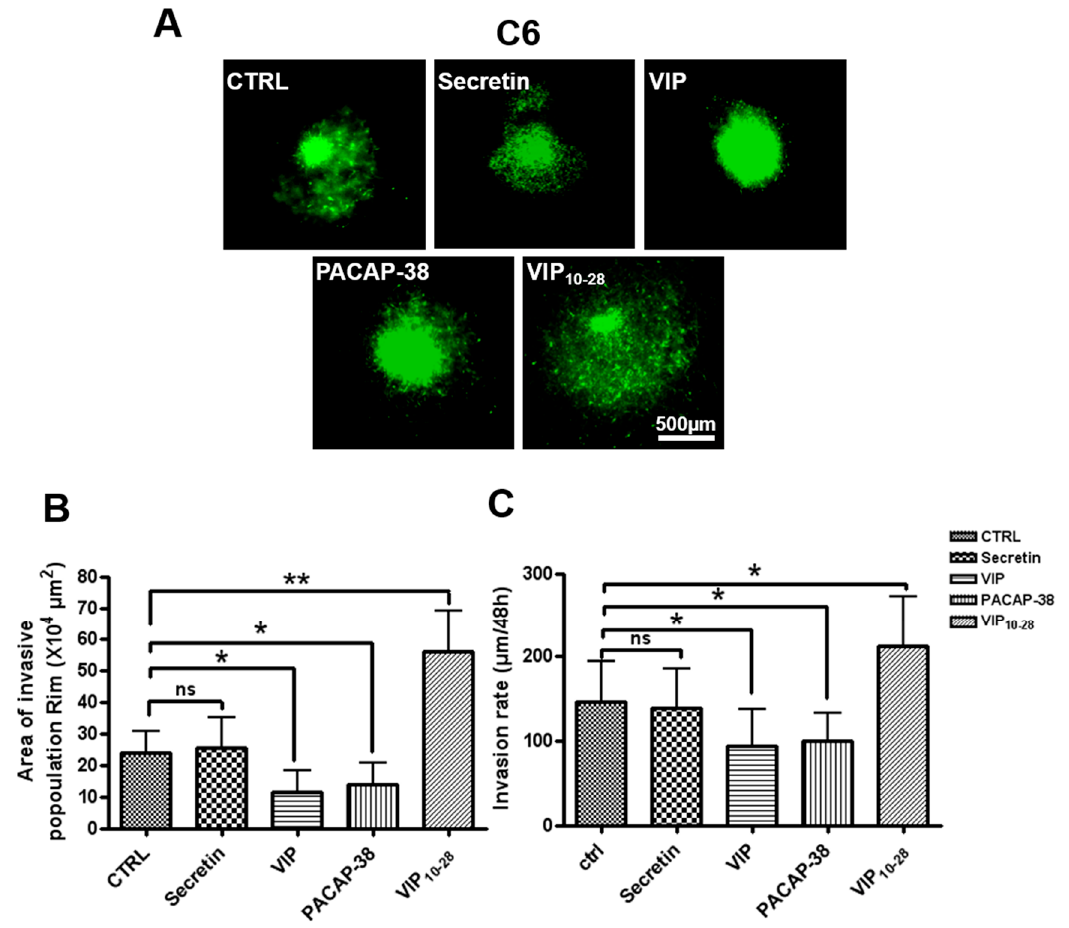
Figure 1. The rat brain slice model system was used to measure ex vivo C6 cell invasiveness. C6 cells stably expressing GFP were transplanted into the center of the putamen in brain slices. Then brain slices were treated or not (CTRL, control) with 10 -6 M of secretin, vasoactive intestinal peptide (VIP), PACAP-38, or VIP 10-28 , and the C6 cells were allowed to invade for 48 h. ( A ) Images were taken with a macroscope. ( B ) The area of GFP-stained cells in invasive population (RIM) in each section was measured. ( C ) The depth of invasion at 48 h was determined using the confocal microscopy. The values are the mean ± SD of quantification of glioblastoma (GBM) invasion in eight different brain slices, obtained from three independent experiments for each experimental condition. About 4–5 newborn rats were necessary to obtain 10 usable brain slices. Data were analyzed using the Kruskal–Wallis test and Dunn’s post hoc test (* p < 0.05; ** p < 0.01).